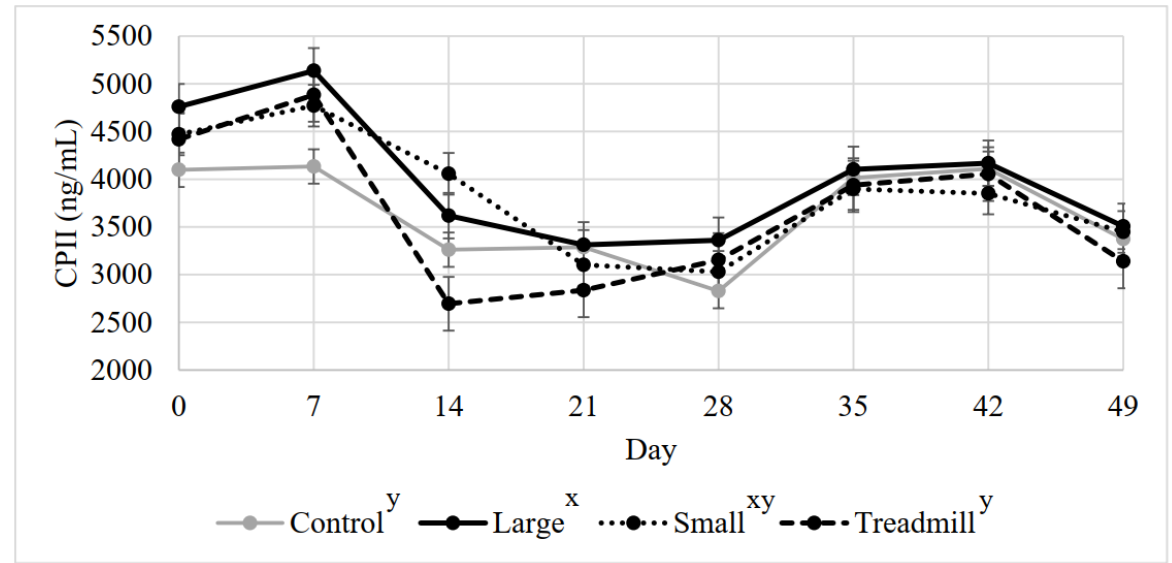
Figure 3. Mean calf procollagen II c-propeptide (CPII) by treatment throughout the 7-week study period. x, y Treatments lacking common superscripts have a tendency to differ ( p = 0.08).